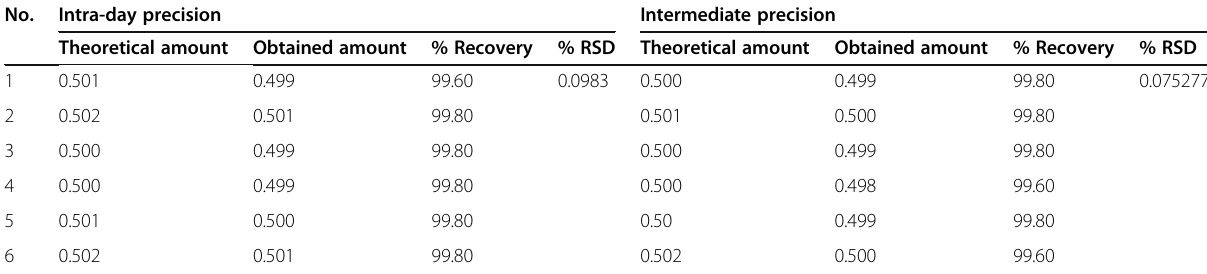
Table 2 A system-generated cumulative result of a precision study of entecavir No. Intra-day precision Intermediate